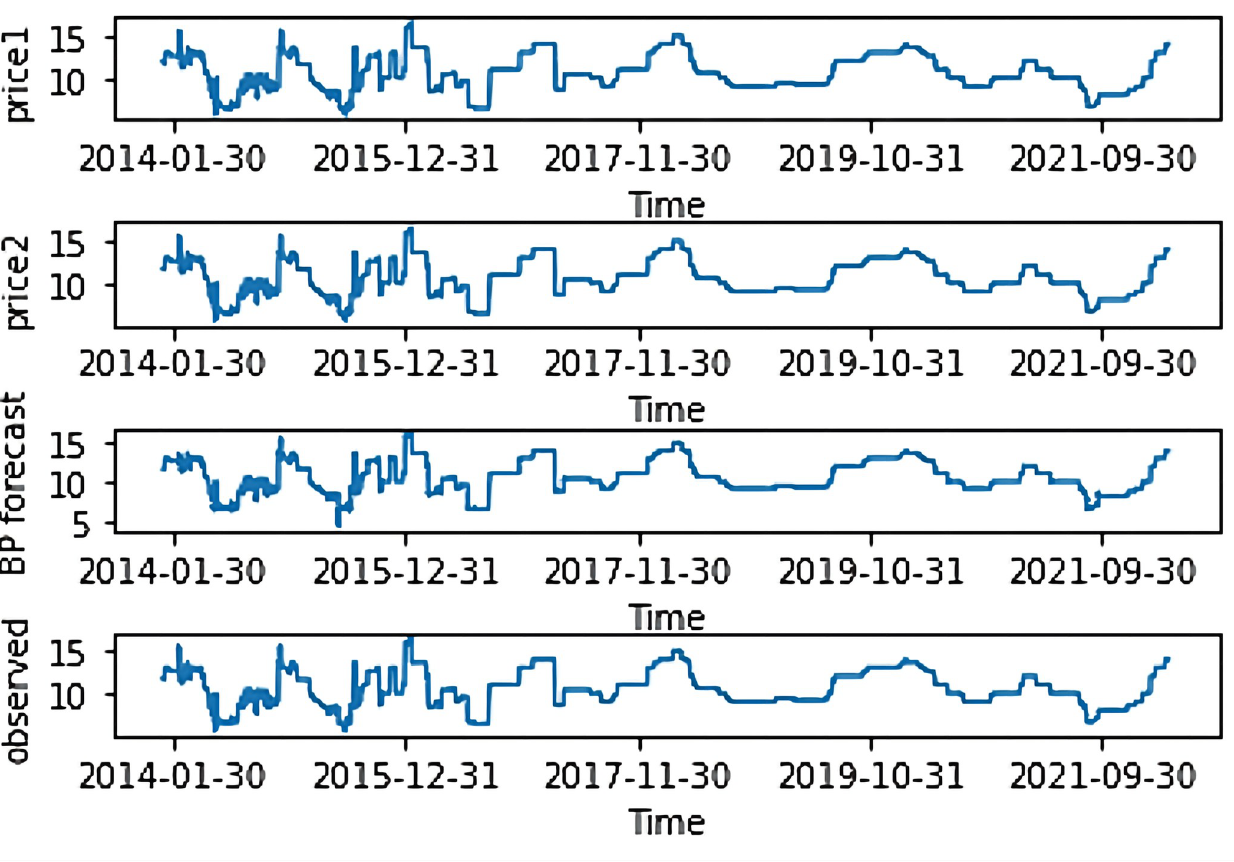
Fig 7. Data used in the back-propagation long short-term memory